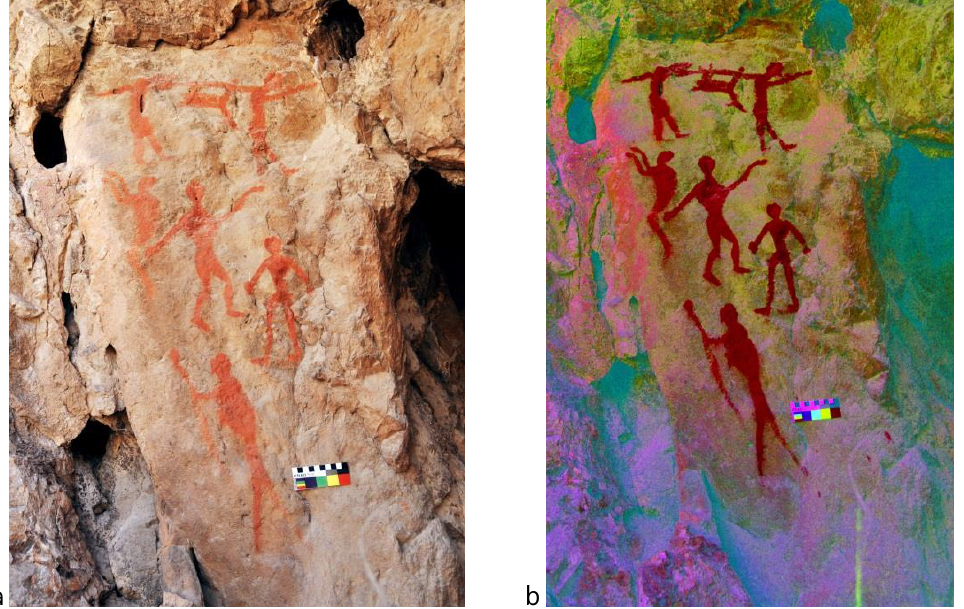
Figure 11. Kuh-e-Donbeh, Site IV. ( a ) Dancing scene. ( b ) Same photo enhanced using Dstretch.